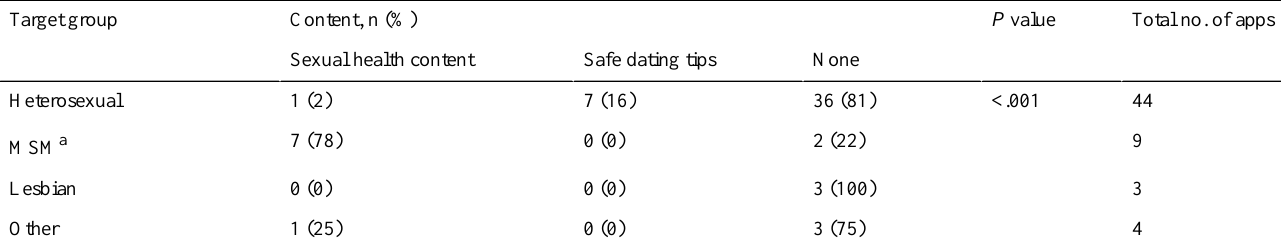
Table 3. Availability of sexual health content and safe dating tips in dating and entertainment apps according to target group.